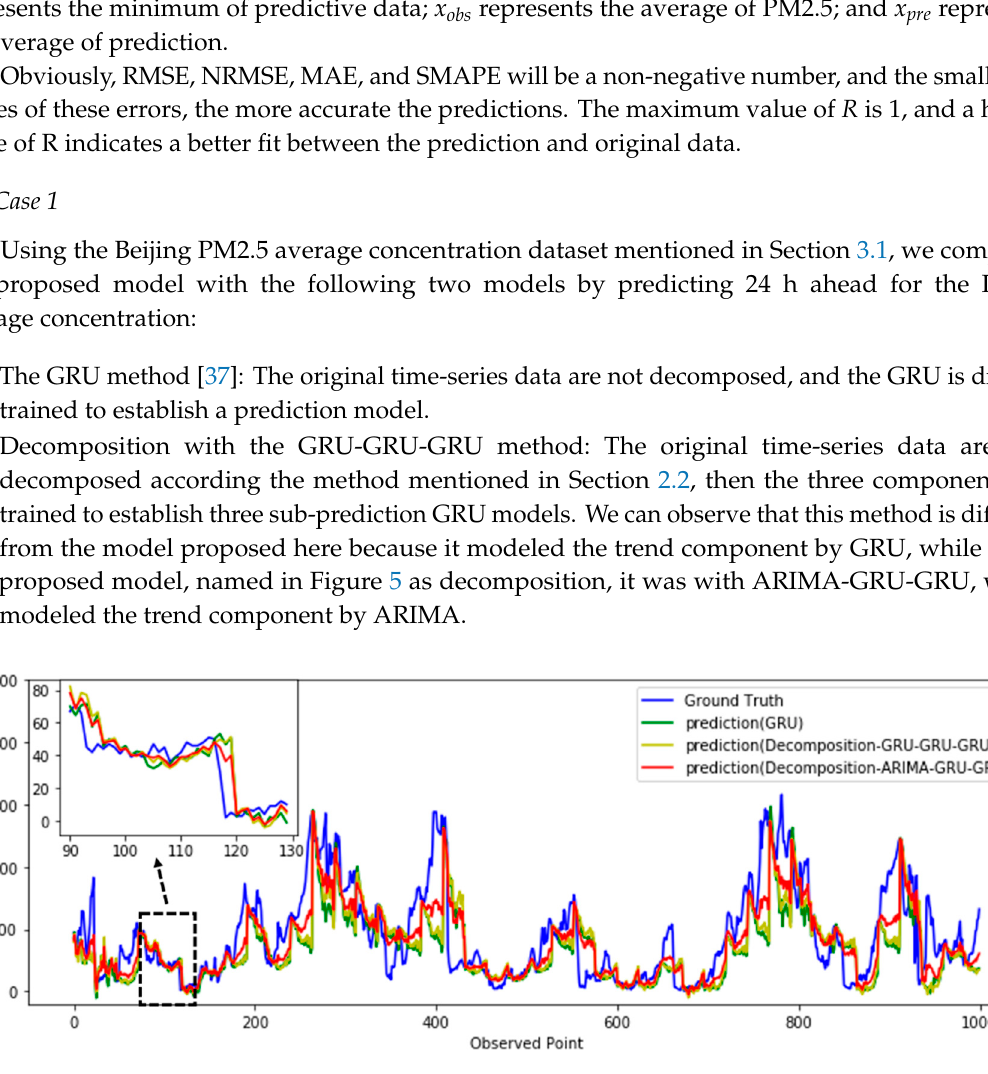
Figure 6. Absolute error between the predicted results and ground truth (24 steps).